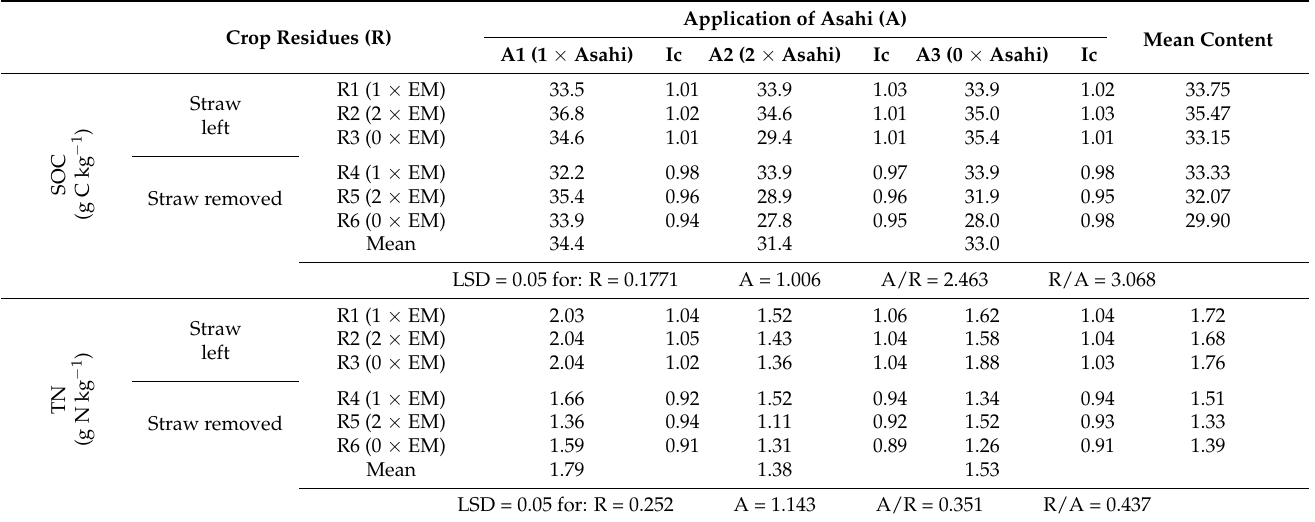
Table 3. Content of SOC, TN, and Ic in the soil, depending on the management of plant residues with the addition of the biopreparation EM (R factor) and the application of the biostimulant Asahi (A factor) in spring barley